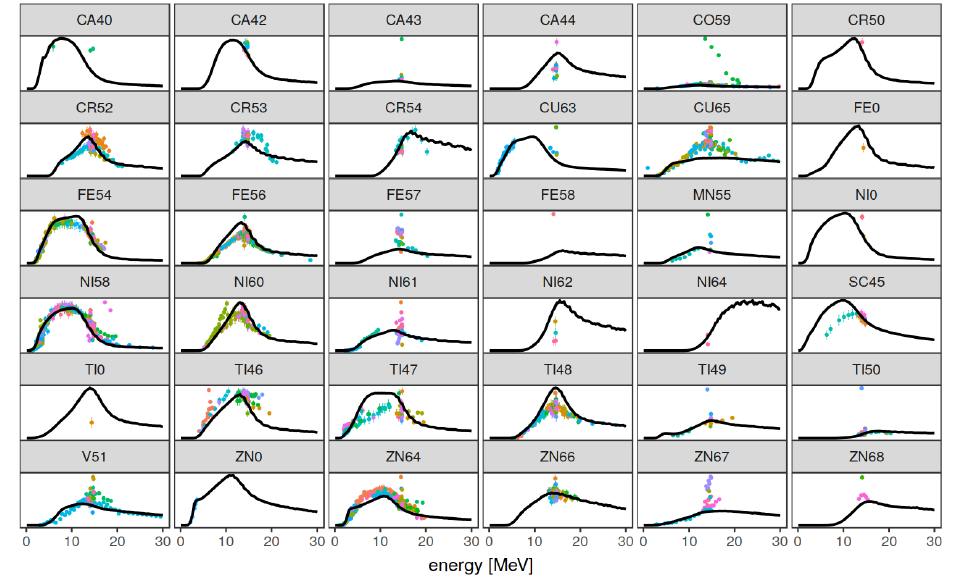
Figure 1. Experimental data for angle-integrated (n,p) cross sections of isotopes with charge numbers between 20 and 30 used for the marginal likelihood maximization. Uncertainties of experiments are assumed to be 10% and independent across data points. An energy of zero corresponds to the threshold energy of the reaction. The mass number zero indicates natural composition. No e ff orts have been made to identify outliers or assess the quality of the data sets. The data were retrieved from 207 entries of the EXFOR database.